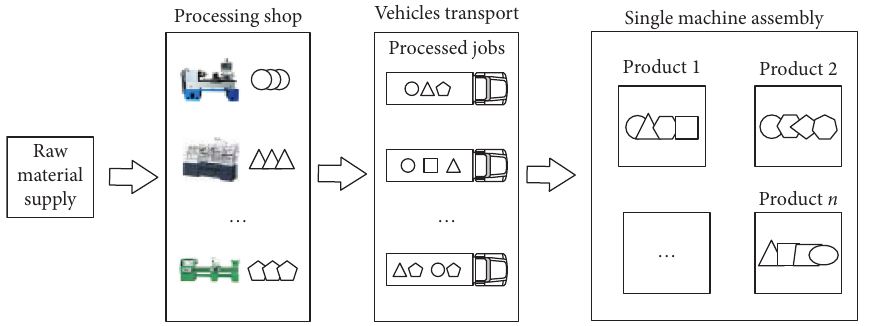
Figure 1: The problem model of